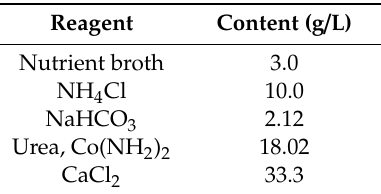
Table 2. Standard composition of cementation solution 0.5 M (solvent in artificial seawater).